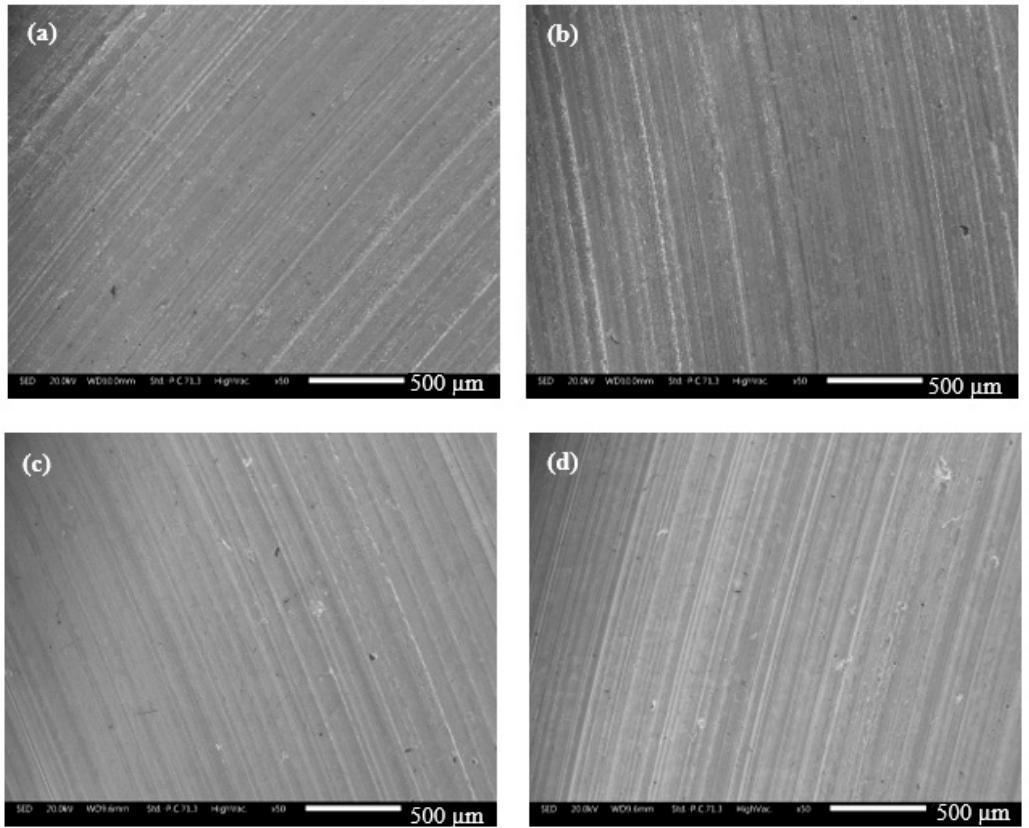
Figure 14. Worn surfaces of discs ( a ) CFM; ( b ) CFM with 10 PP; ( c ) CFM with 15 PP; and ( d ) CFM with 20 PP.